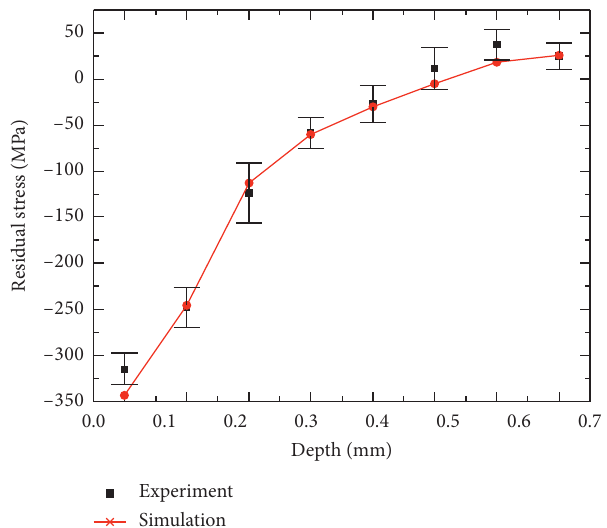
Figure 21: Residual stress distribution curves of the in-depth direction of the